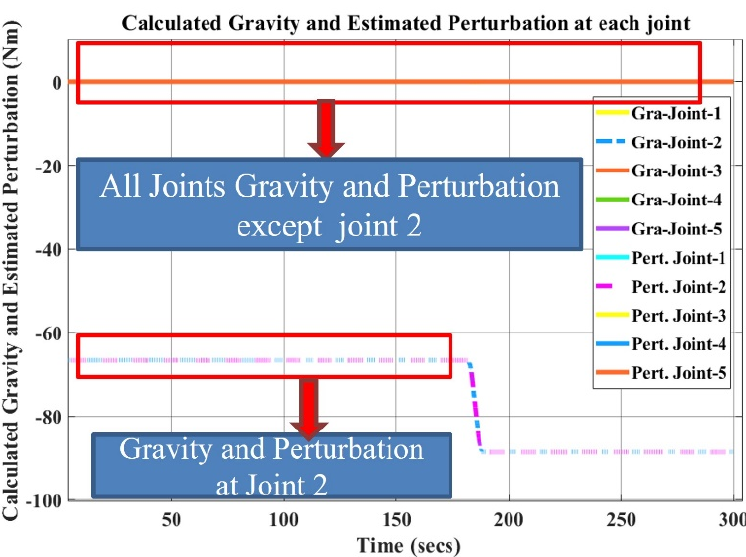
Figure 5. Comparison between calculated gravity and SPO.